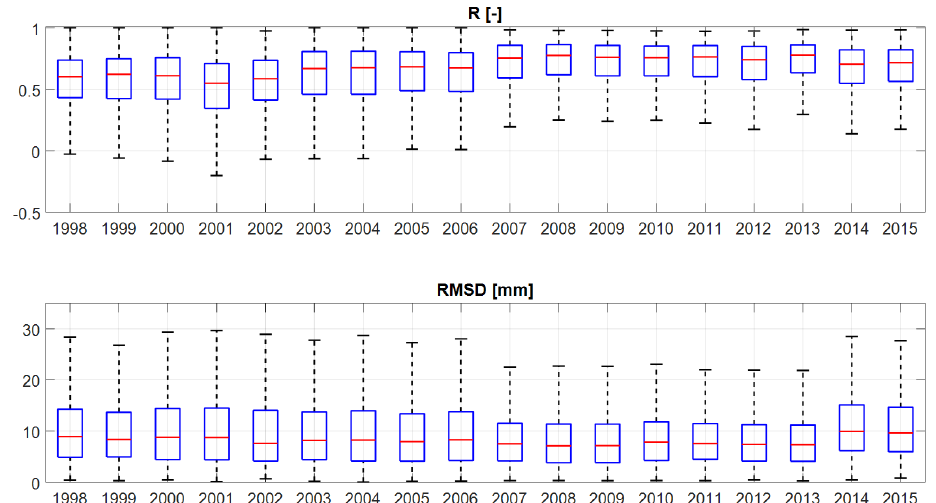
Figure 7. Yearly box plots for the correlation coefficients ( R ) and root mean square differences (RMSDs, in mm) between SM2RAIN-CCI and MSWEP obtained on a global scale at 0.25 ◦ spatial resolution during the period 1998–2015. For each box, the red line represents the median values and the blue box represents the 25th and 75th percentile, while the black dotted whiskers extend to the most extreme data